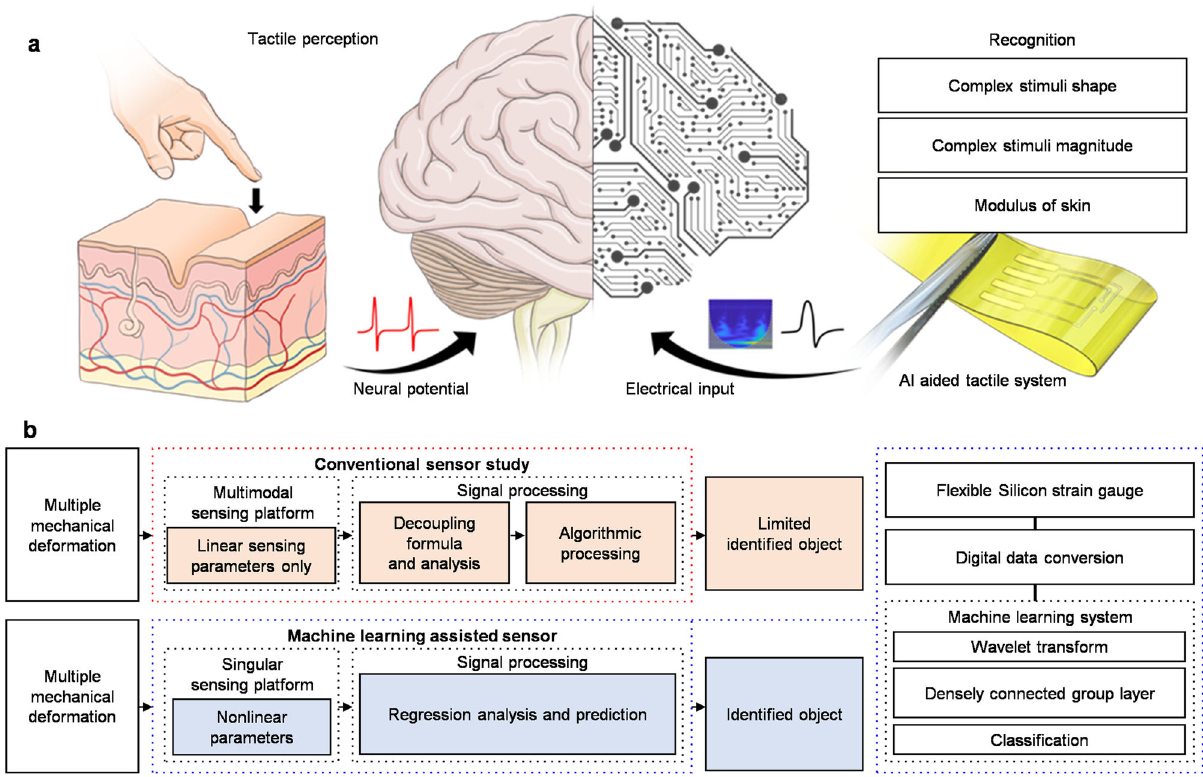
Fig. 1 Conceptual schematic and block diagram of the operating piezoresistive system. a The schematic illustrates the mechanical activation of sensory receptors in the surface of the skin and associated neuronal action potential that results in the interpretation of stimuli in the somatosensory cortex (left). The arti fi cial sensor with computer neural network yields the machine-aided recognition of the different stimulator types and of the mechanical modulus to which the sensor is attached (right). b Block diagrams compare the sequence of the stimulator recognition in the conventional (above) and the deep learning-aided (below) arti fi cial sensing system. The latter includes a neural computer network that enables the classi fi cation of the digitized output pattern from the fl exible piezoresistive sensing